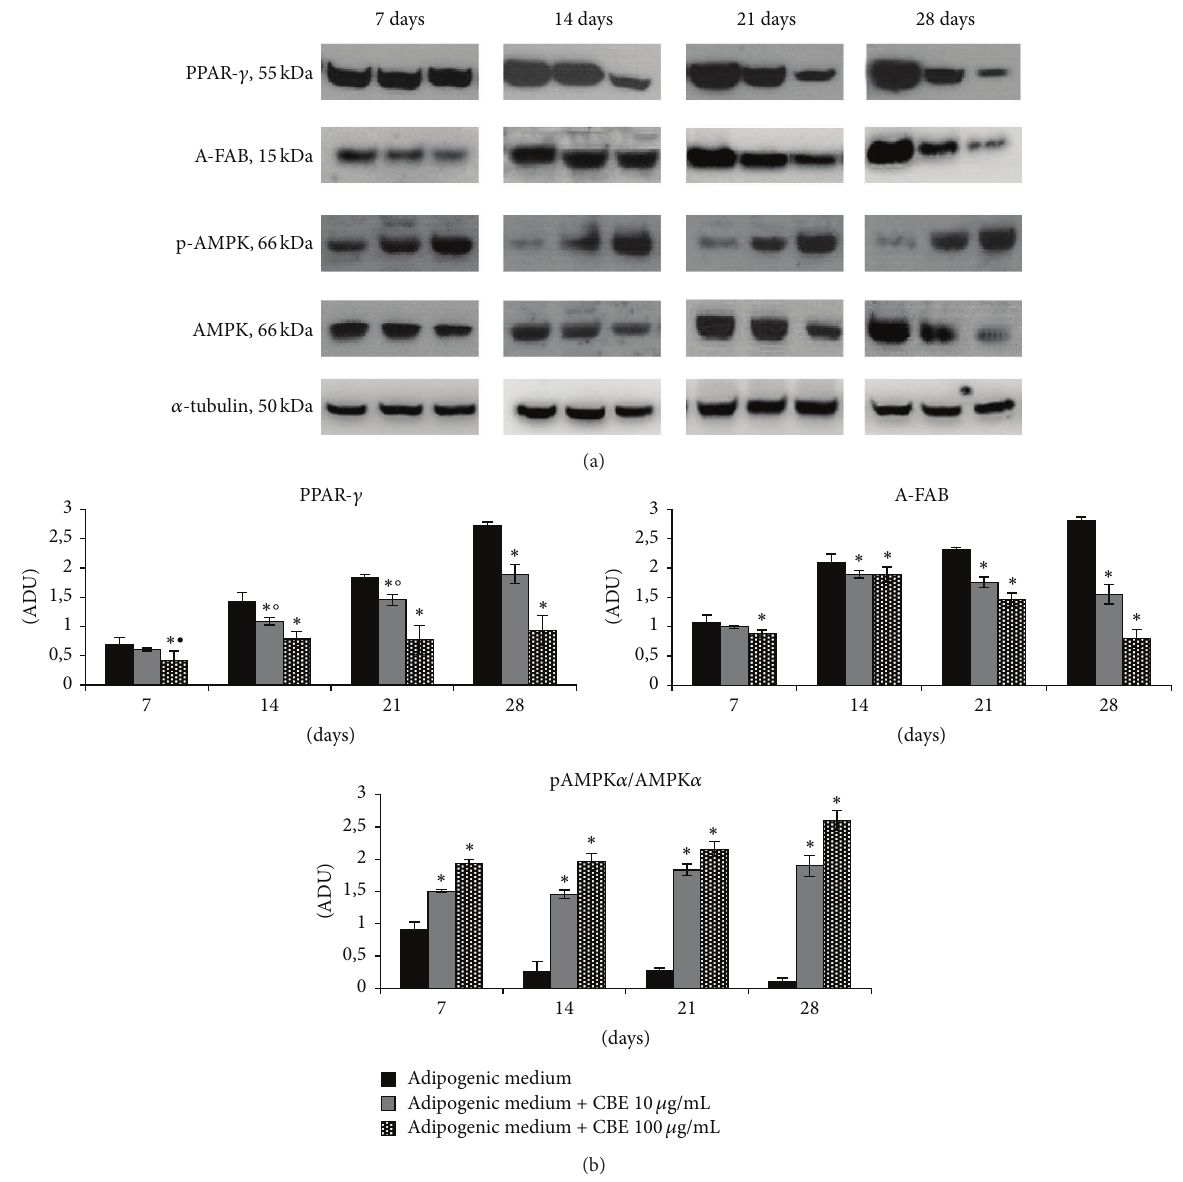
Figure 4: Inhibitory effects of 10 or 100 𝜇 g/mL Citrus bergamia extract (CBE) on adipocyte differentiation in mesenchymal stem cells induced to differentiate into adipocytes by using adipogenic medium in presence or absence of CBE. At 7, 14, 21, and 28 days, differentiated mesenchymal stem cells adipocytes were examined for PPAR- 𝛾 , A-FAB, AMPK 𝛼 1/2, and p-AMPK 𝛼 1/2 by Western blot. The levels of proteins were expressed as arbitrary densitometric units (ADU) and the ratio p-AMPK 𝛼 1/2/AMPK 𝛼 1/2. Data are shown relative to adipogenic-treated cells and expressed as mean ± SD from three independent experiments. ∗ 𝑝 < 0.01 versus the mesenchymal stem cells treated with adipogenic medium at same day; ∘ 𝑝 < 0.01 versus CBE 10 𝜇 g/mL at 28 days; ∙ 𝑝 < 0.01 versus CBE 100 𝜇 g/mL at 28